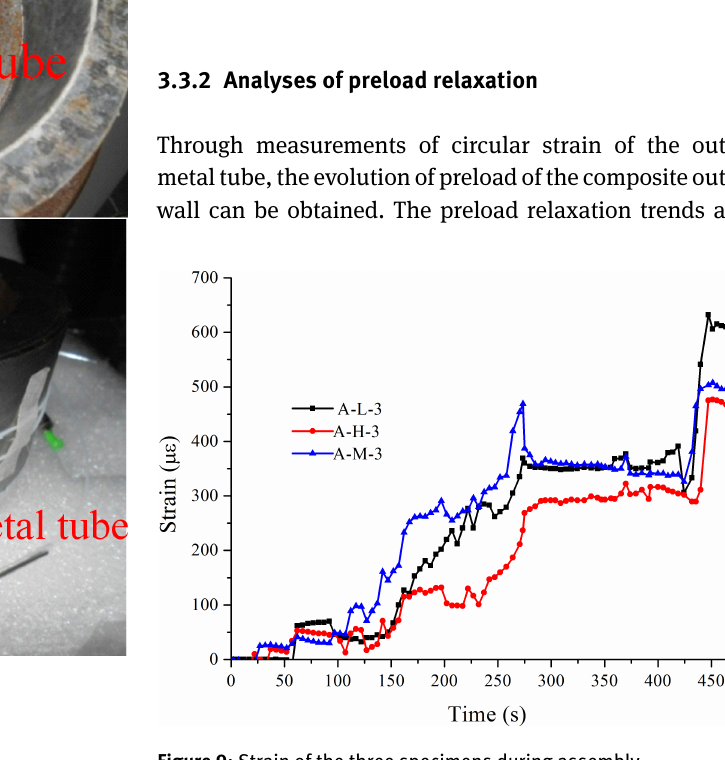
Figure 9: Strain of the three specimens during